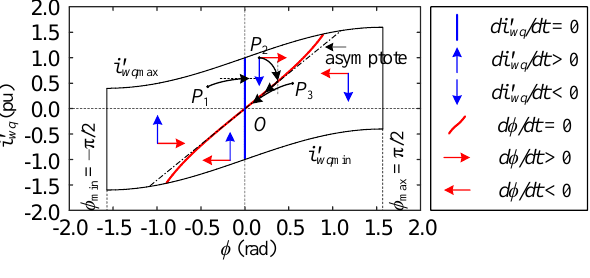
Figure 8. Phase plane ϕ − i ′ wq with the Q - f control.